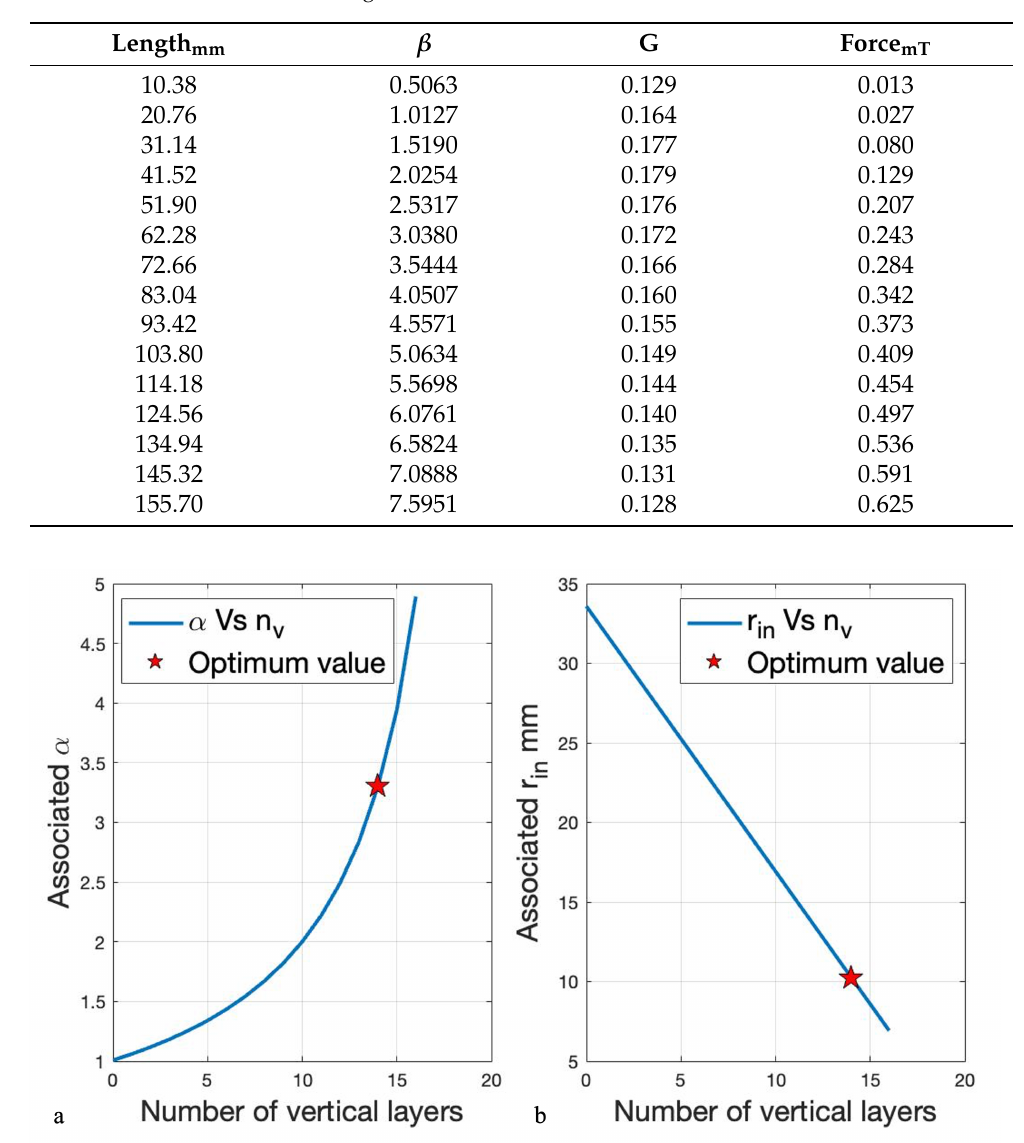
Figure 9. ( a ) Number of layers from the inner radius toward outer radius for various α . ( b ) Inner radius calculation based on the number of layers for different α